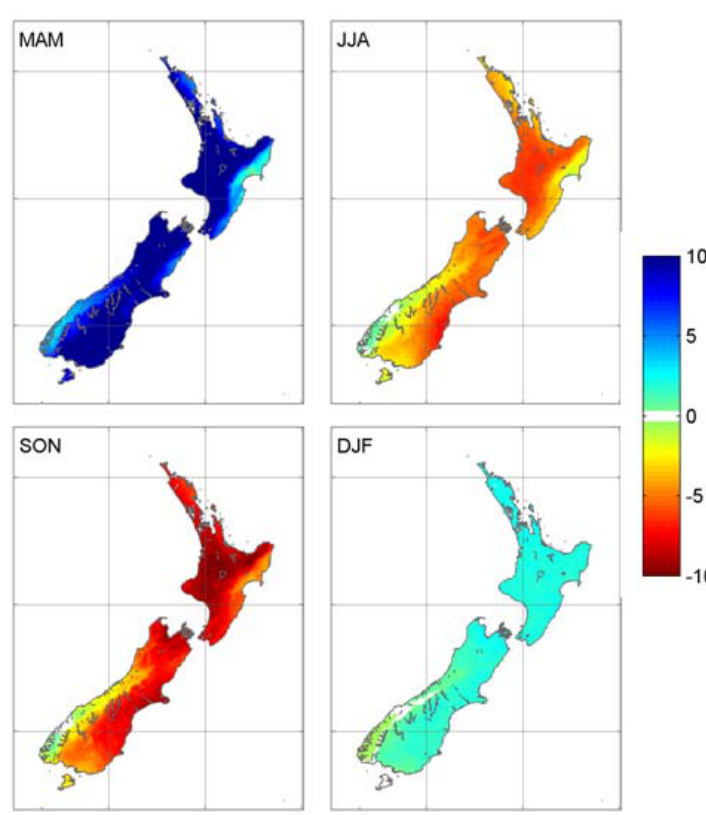
Fig. 8. The same as Fig. 7 except for the precipitation anomaly